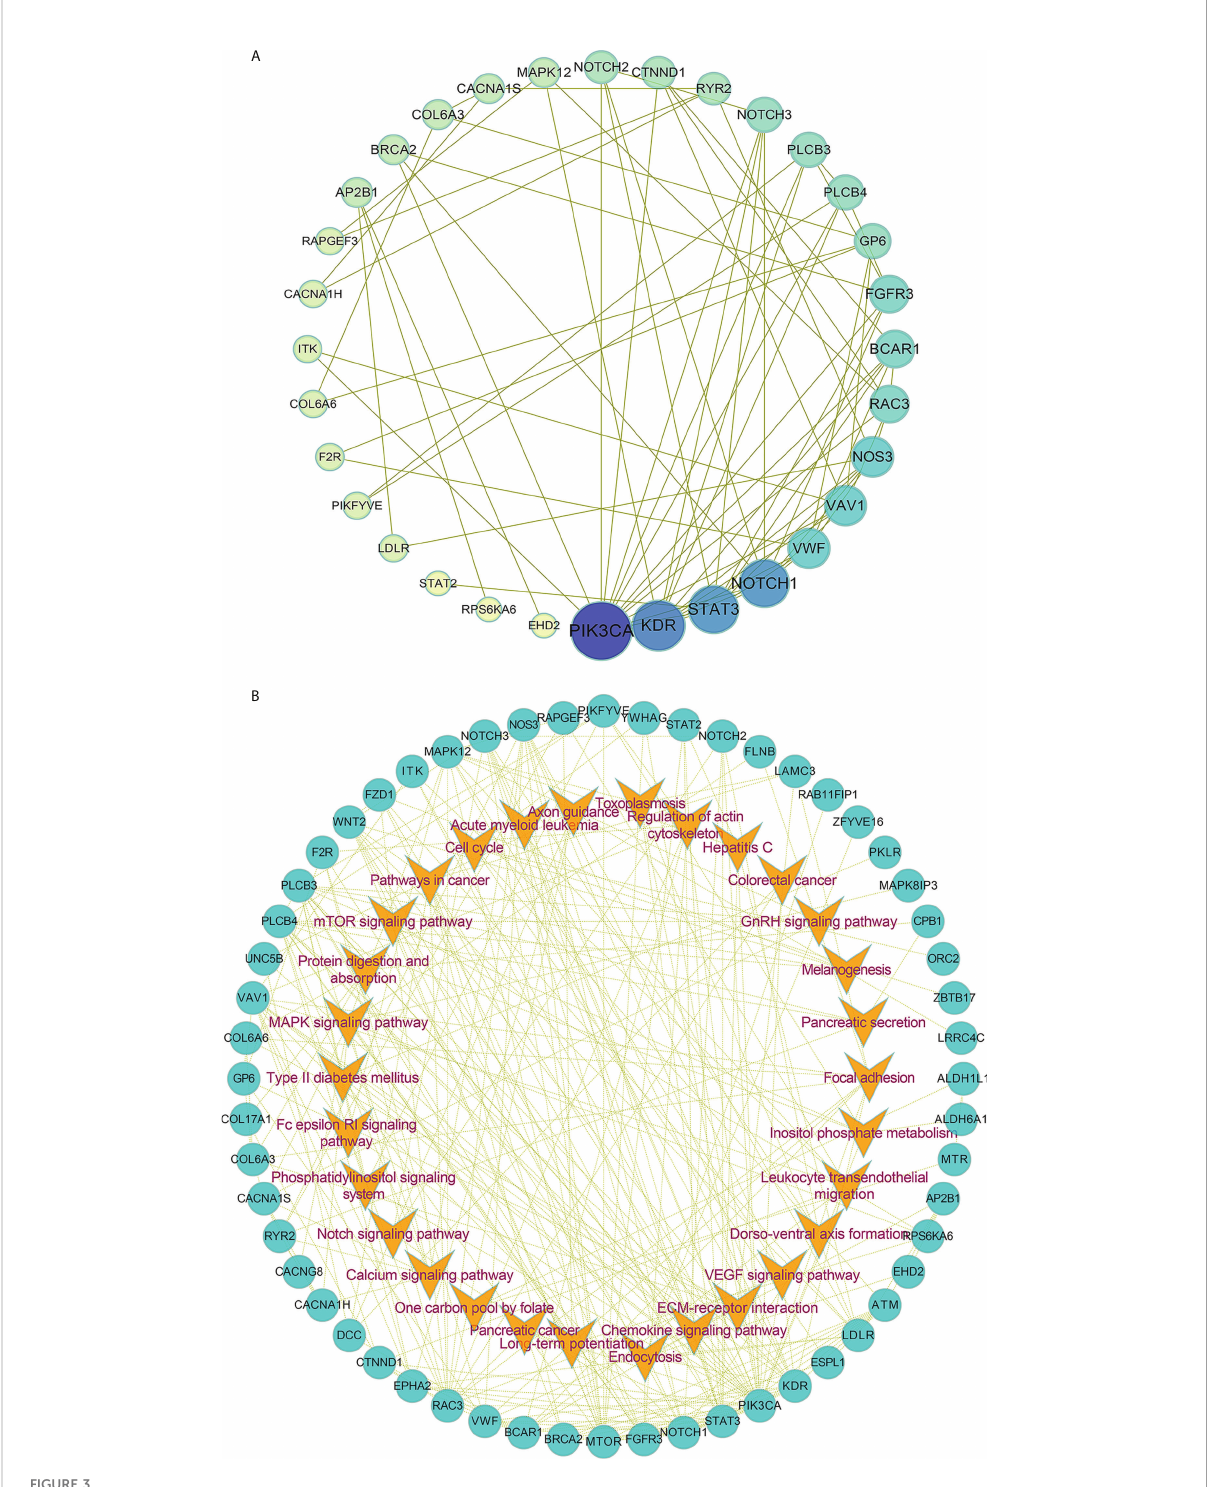
FIGURE 3 The protein-protein interaction network in ESCC. (A, B) The protein-protein interaction network (A) by utilizing the differentially mutated genes and pathway-based protein interaction (B) were